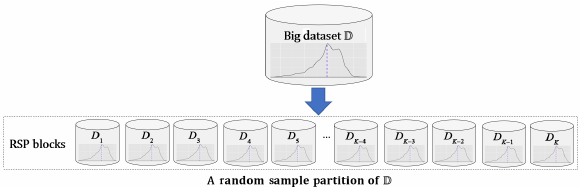
Fig. 5 Random sample partition distributed data